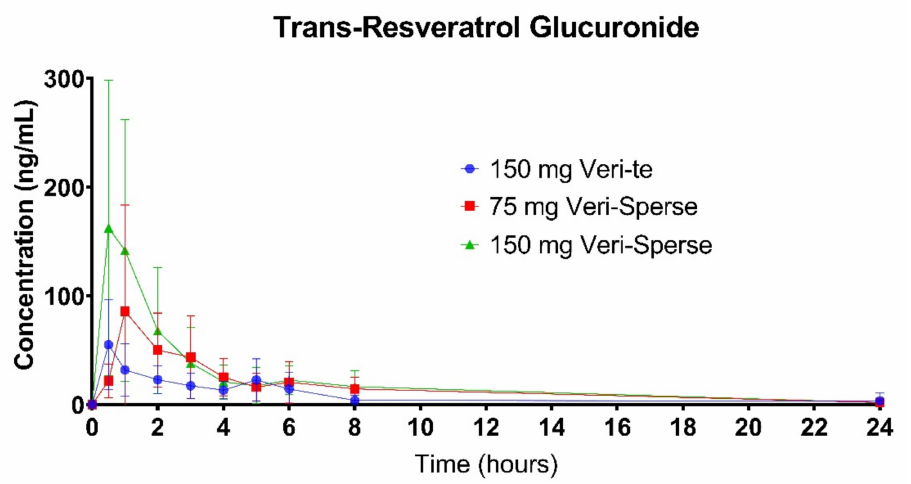
Figure 2. Plasma concentration of the trans-resveratrol glucuronide conjugates over 24 h after a single dose.